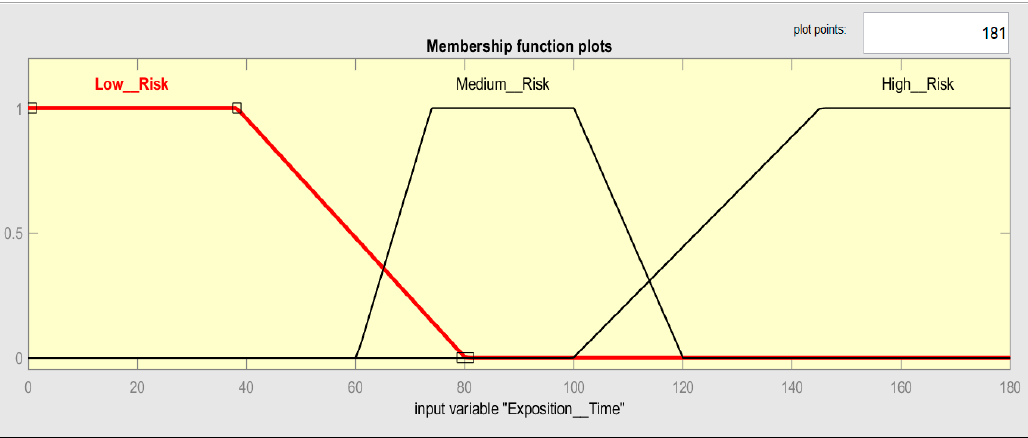
Table 5. Ranges of time of exposition and their fuzzy sets.